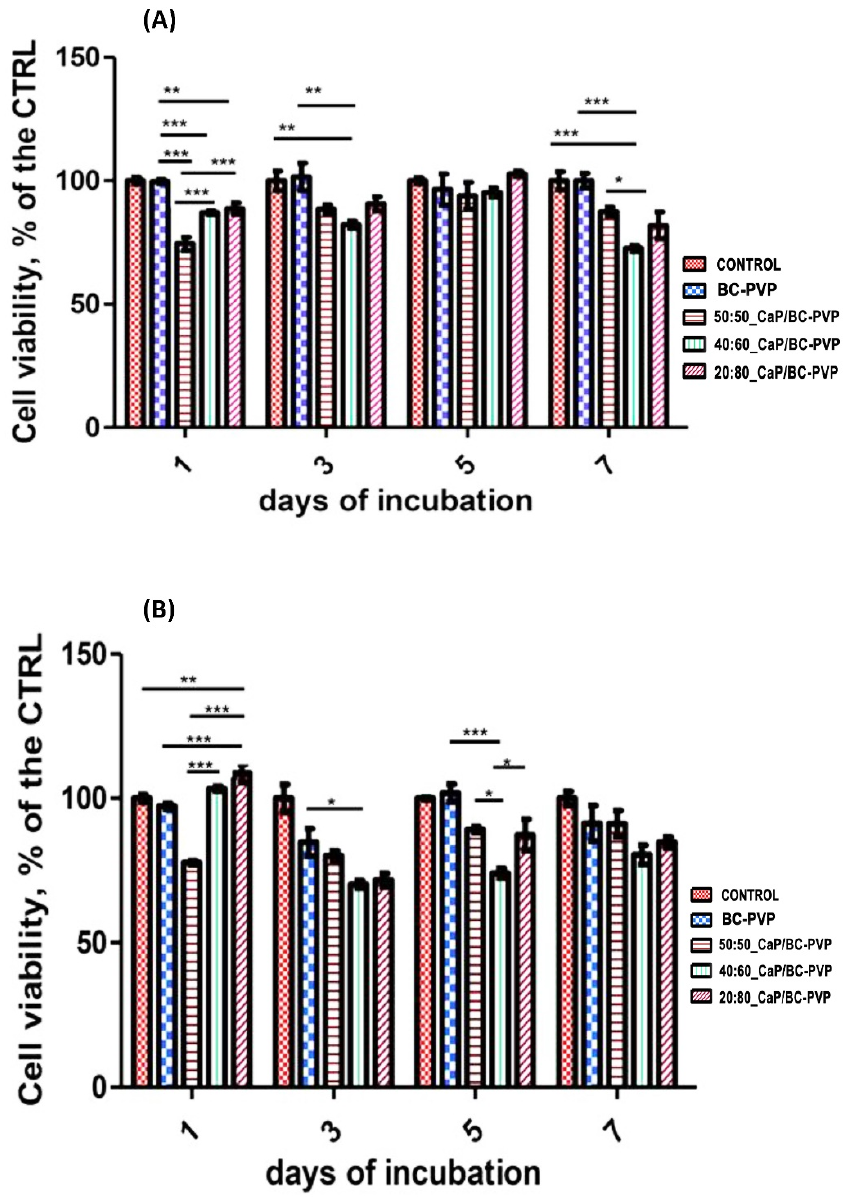
Figure 8. Direct and indirect cell viability for CaP/BC-PVP hydrogel scaffold with Saos-2. ( A ) Indirect experiment (IDE) and ( B ) direct experiment (DE). The asterisks indicate the level of significance (***P < 0.0001, **P < 0.001, *P < 0.05) in cell viability/proliferation.